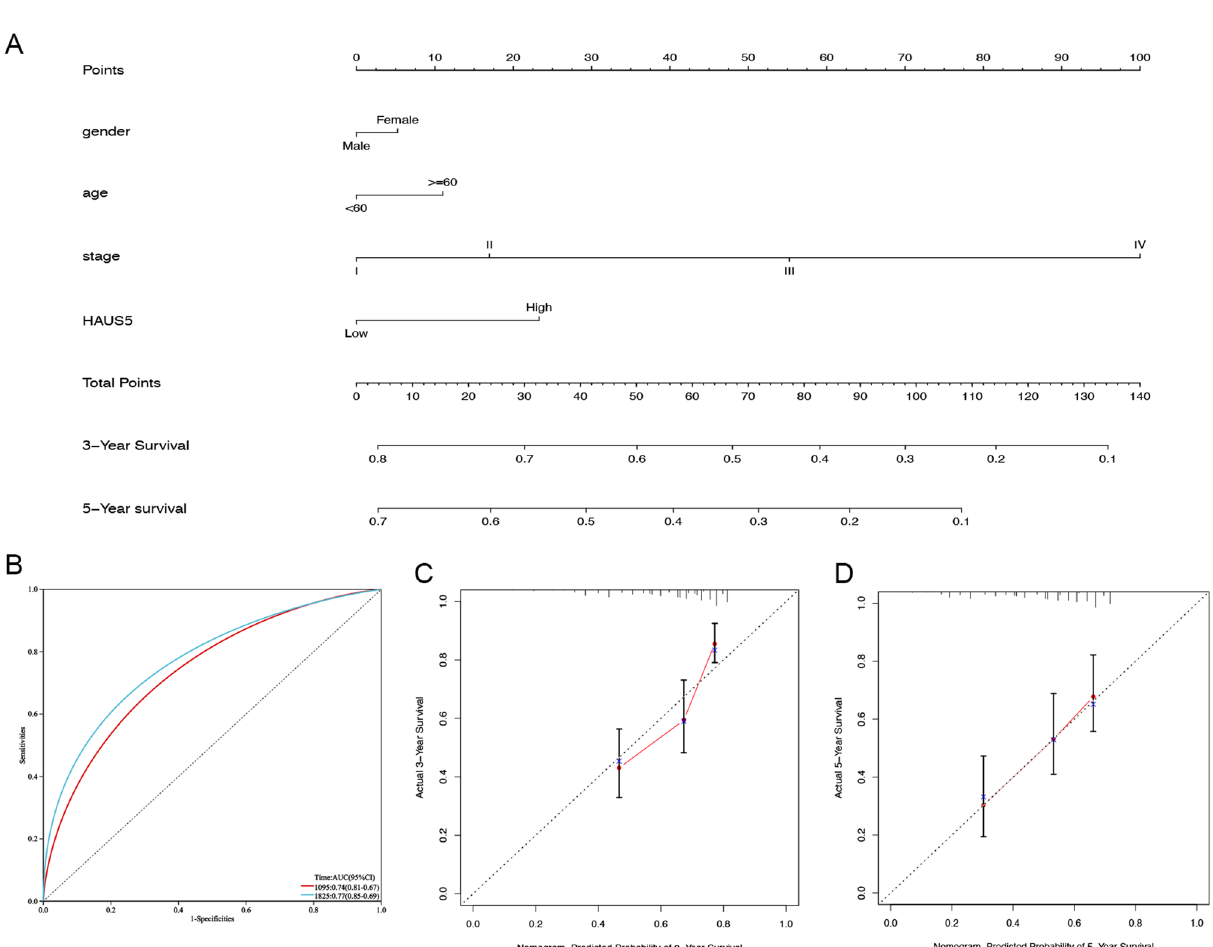
Figure 6. Construction and evaluation of a nomogram to predict 3- and 5-year OS in LIHC patients. ( A ) The nomogram was applied to predict the 3- and 5-year OS of LIHC patients, and the total score on the bottom scale implies the probability of OS. ( B ) ROC curves to evaluate the nomogram accuracy for predicting 3- and 5-year OS in LIHC patients. ( C , D ) Calibration curves of the nomogram for the prediction of survival rates at 3 and 5